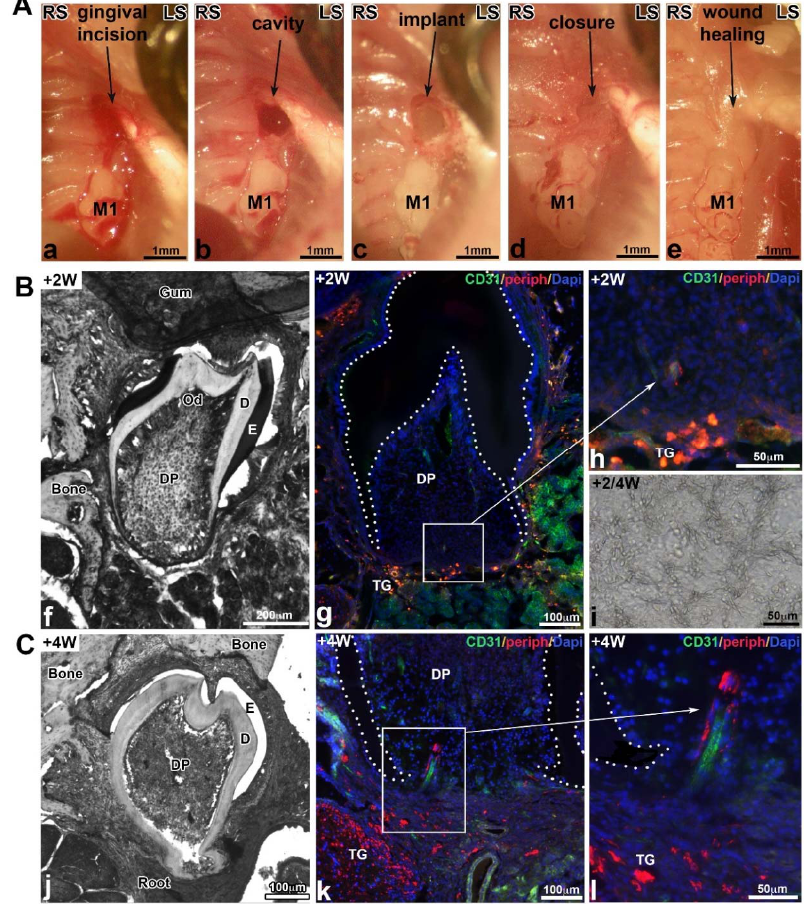
Figure 6. ( A ) Different stages of the microsurgery: incision of the gingiva ( Aa ), maxillary bone lesion obtained with a dental bur (500 μ m) ( Ab ), implantation of the membrane with the bioengineered tooth and TG ( Ac ), closing of the gingiva with biological glue ( Ad ), and wound healing of the mucosa two weeks after implantation ( Ae ). ( B , C ) Histology, vascularization and innervation of bioengineered tooth implanted on PCL scaffolds functionalized with CsA ‐ loaded PLGA nanoparticles (chitosan/PLGA/CsA) 5 after two ( B ) or four ( C ) weeks of implantation. Samples were embedded in Tissue ‐ Tek, frozen at − 20 °C and sectioned (10 μ m) using a cryostat (Leica, CM3000). Serial sections were rinsed with PBS, fixed for 10 min with 4% paraformaldehyde at 4 °C. Some were stained with hematoxylin/eosin (( Cf ),( Ci ),( Cj )) or for the immunofluorescence as previously described using rabbit anti ‐ peripherin (Abcam, dilution 1/600) and rat anti ‐ CD31 (BD Pharmingen, dilution 1/100) antibodies [22] (( Bg ),( Bh ),( Ck ),( Ci )). Cell nuclei were stained with 200 nM DAPI (Sigma ‐ Aldrich Co, Darmstadt, Germany). D: dentin, DP: dental pulp, E: enamel, M1: first upper molar, Od: odontoblasts, TG: trigeminal